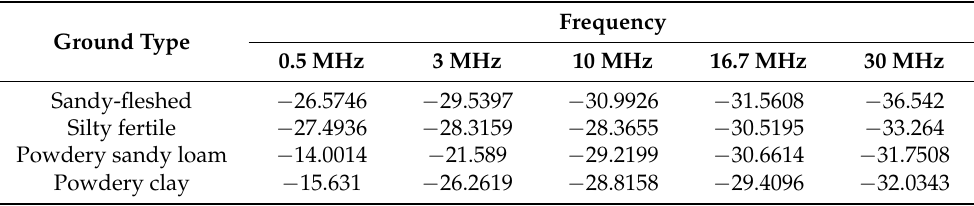
Table 3. The minimum value of RCS normalization under different rough surfaces.